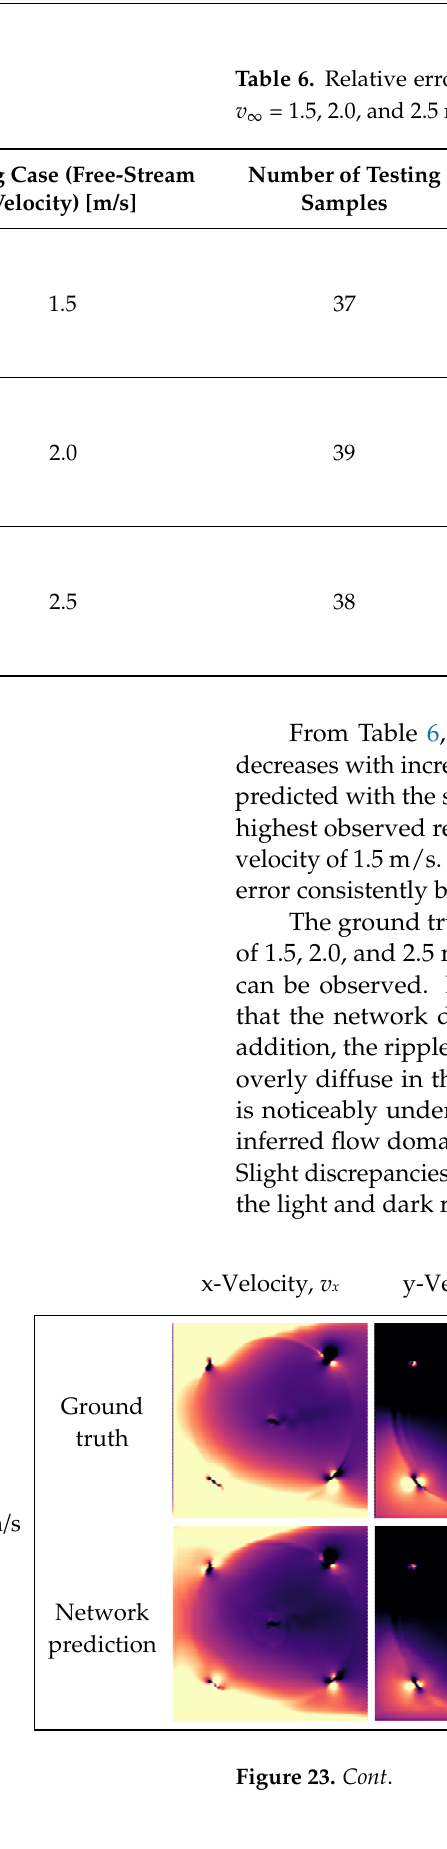
Figure 23. Ground truths and network predictions of Model 2 for the testing cases of v ∞ = 1.5, 2.0, and 2.5 m/s. 3.3.3. Model 3: Small Architecture with Three Training Cases Model 3 was tested using simulation results for the free-stream velocities of 2.0 and 2.5 m/s. The minimum, maximum, and average relative errors produced for each testing case are shown in Table 7.